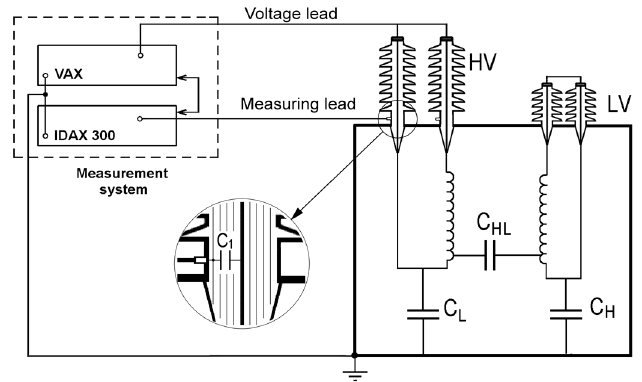
Figure 12. Test system for the measurement of the dielectric response of bushings.